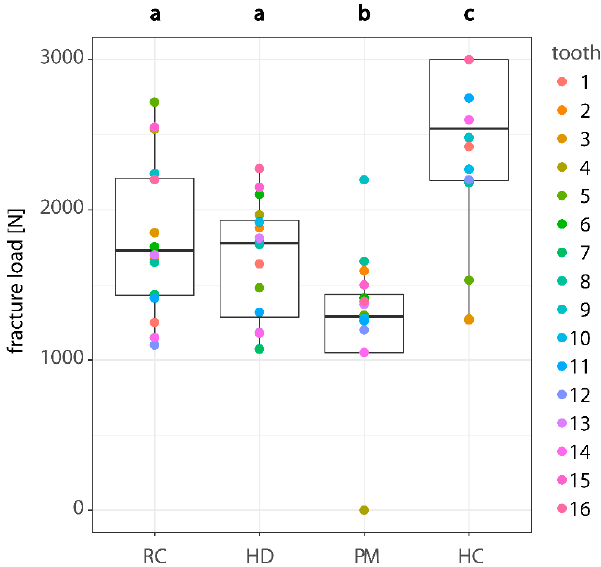
Figure 3. Fracture load (N) according to used abutment material. Dots of same color correspond to specimens with same morphology. Di ff erent lowercase letters indicate statistically significant di ff erence of estimated means among abutment materials RC, HD, PM and HC. Medians were 2540 N for HC, 1778 N for HD, 1728 N for RC and 1290 N for PM. RC, reinforced composite; HD, human dentin; PM, polymethyl methacrylate; HC, hybrid